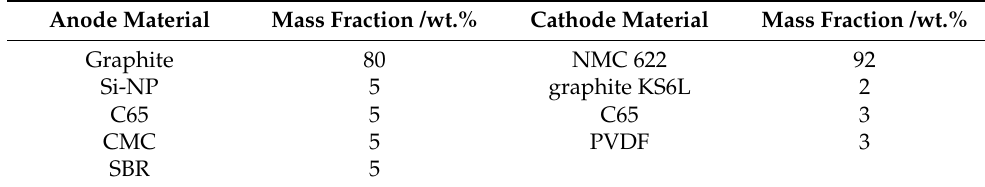
Table 1. Composition of the electrode